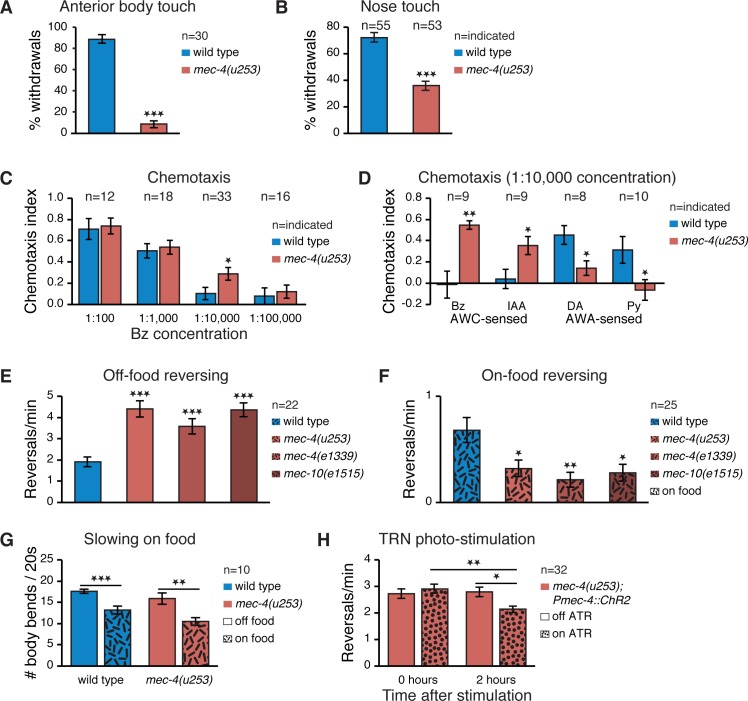
Loss of body touch response results in activity-dependent changes in locomotion and chemotaxis.(A) Percent of withdrawal responses out of five anterior body gentle stimulations of wild-type an Mec mutants. (B) Percent of withdrawal responses out of five gentle nose stimulations of wild type and Mec mutants. Worms defective in sensing body touch also show reduced nose touch responses. (C) Chemotaxis scores of wild type and Mec mutants at varying concentrations of the attractive odorant, Bz. A score of 1 corresponds to perfect attraction; a score of 0 indicates complete indifference. mec-4(u253) mutants outperform wild type at low, 1:10,000, Bz concentrations. (D) Chemotaxis scores of wild type and Mec mutants for 1:10,000 concentrations of AWC-sensed Bz and IAA, and AWA-sensed DA and Py. Chemosensation of AWC-sensed odors is enhanced. Chemosensation of AWA-sensed odors is reduced. (E,F) Reversing frequency off-food (E) and on-food (F) of various Mec mutants. Reversing off-food is increased and on-food is decreased in Mec mutants compared to wild type. (G) Speed off-food and on-food of wild type and Mec mutants. Wild type and Mec mutants exhibit similar slowing on food (2-way ANOVA interaction p = 0.6, main effect of food p < 0.0001). (H) Mec mutant reversing rate off-food immediately or 2 h after artificial stimulation of the TRNs using random blue light flashing, with or without (control) supplemental all-trans retinal (ATR). TRN stimulation reduced the reversing rate of mec-4(u253) mutants towards wild type levels 2 hours later (2-way ANOVA interaction p = 0.014). N2 is the wild type strain. Sample size indicated in each panel; Error bars represent standard errors of the mean (SEMs); *p < 0.05, **p < 0.01, ***p < 0.001 t test with Bonferroni corrections for multiple comparisons where relevant.